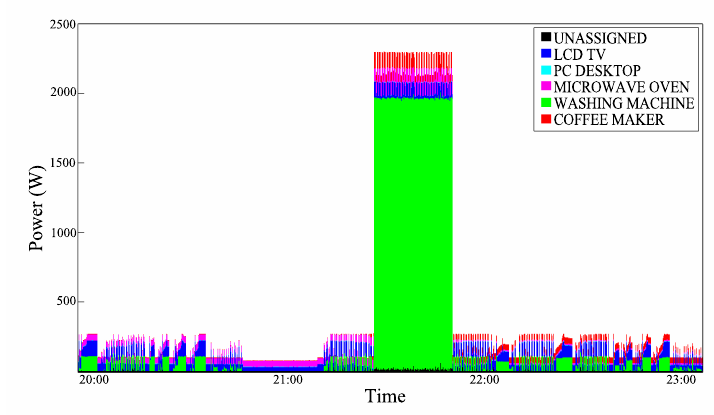
Figure 10. Power consumption disaggregation obtained with the UP Single Interval Conditioning —test case 2.